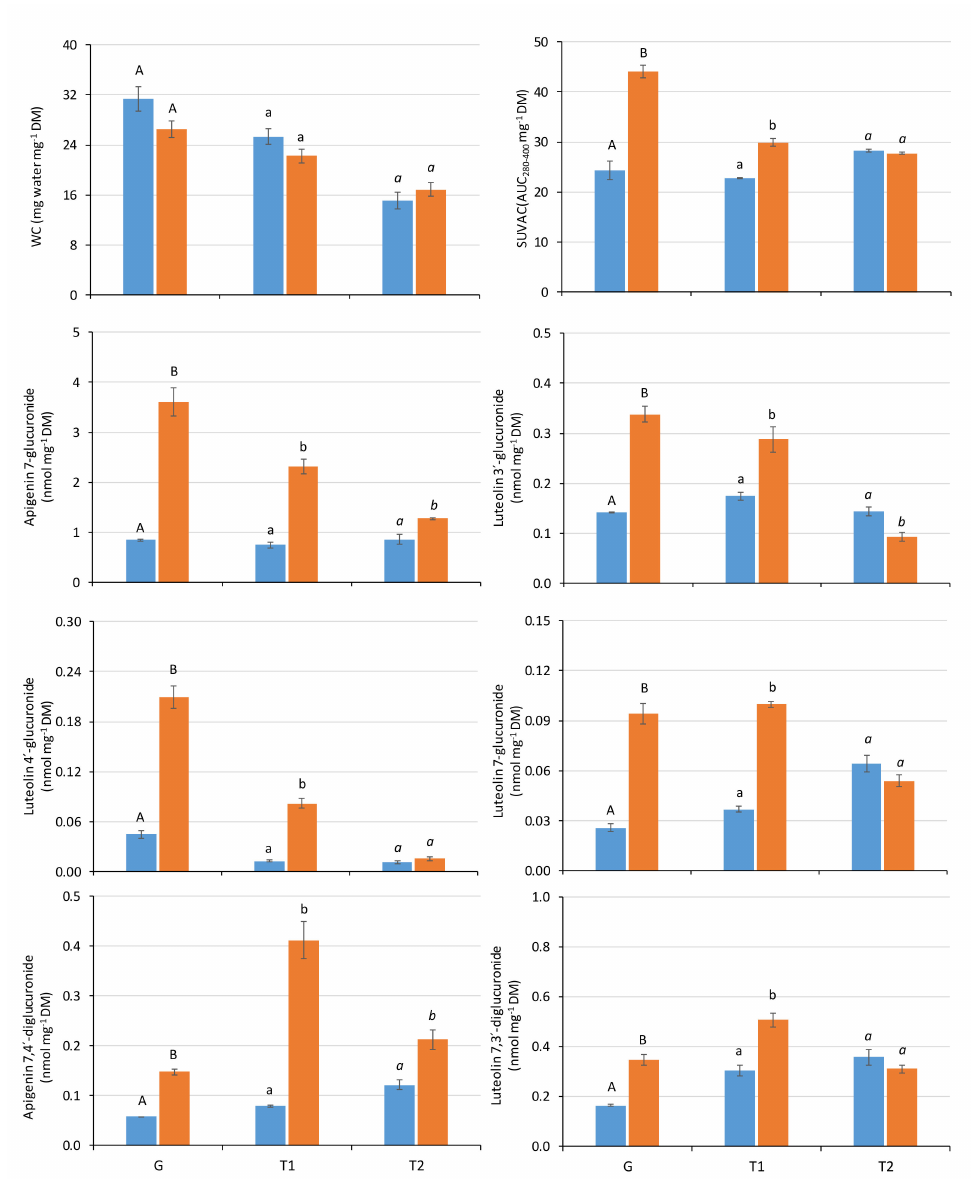
Figure 2. Water content (WC) values, bulk levels of soluble UV-absorbing compounds (SUVAC, in terms of the area under the absorbance curve in the interval 280–400 nm (AUC 280–400 ) per DM unit), and contents of individual soluble UV-absorbing compounds in Marchantia polymorpha subsp. ruderalis Tak-1 samples, measured after 38 days of exposure to two different radiation regimes: P (only PAR, blue bars) and PAB (PAR + UV-A + UV-B, orange bars). Samples were exposed to either P or PAB regimes starting from three different developmental stages: gemmae (G), one-month thalli (T1), and two-month thalli (T2). For each developmental stage, different letters mean significant differences (at least p < 0.05) between radiation regimes (Student’s t